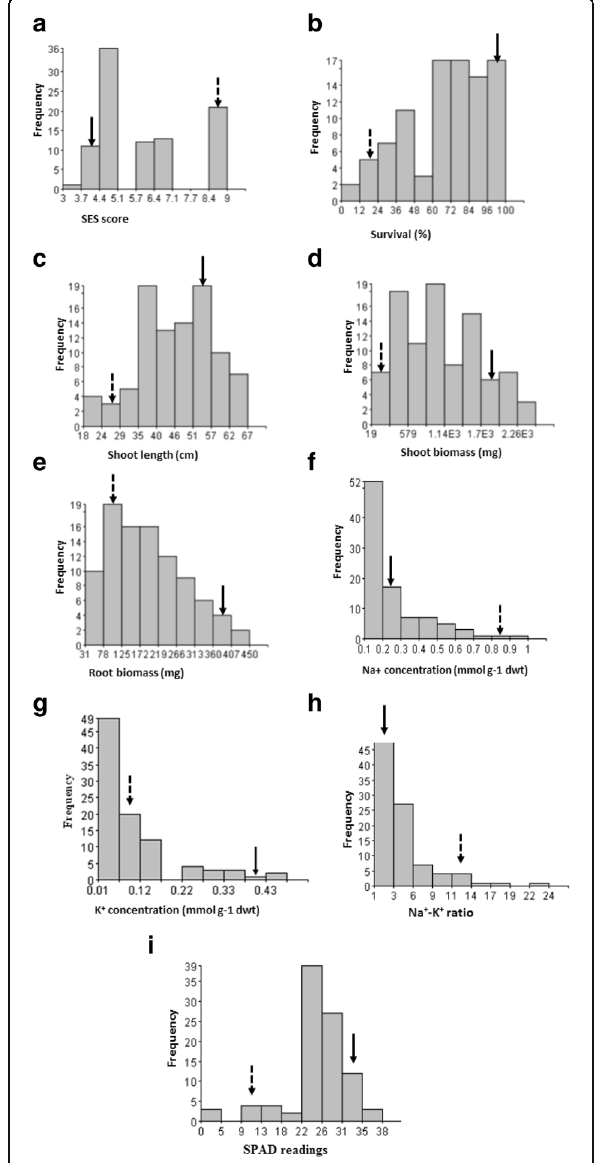
Fig. 1 Frequency distribution (number of plants) of the F 2:3 individuals for traits associated with salinity tolerance at seedling stage; a SES score, b survival c shoot length d shoot biomass e root biomass f Na + concentration g K + concentration h Na + -K + ratio, and i SPAD readings. Solid and dotted arrows indicate the phenotypic value of the tolerant parent Capsule and sensitive BR29,